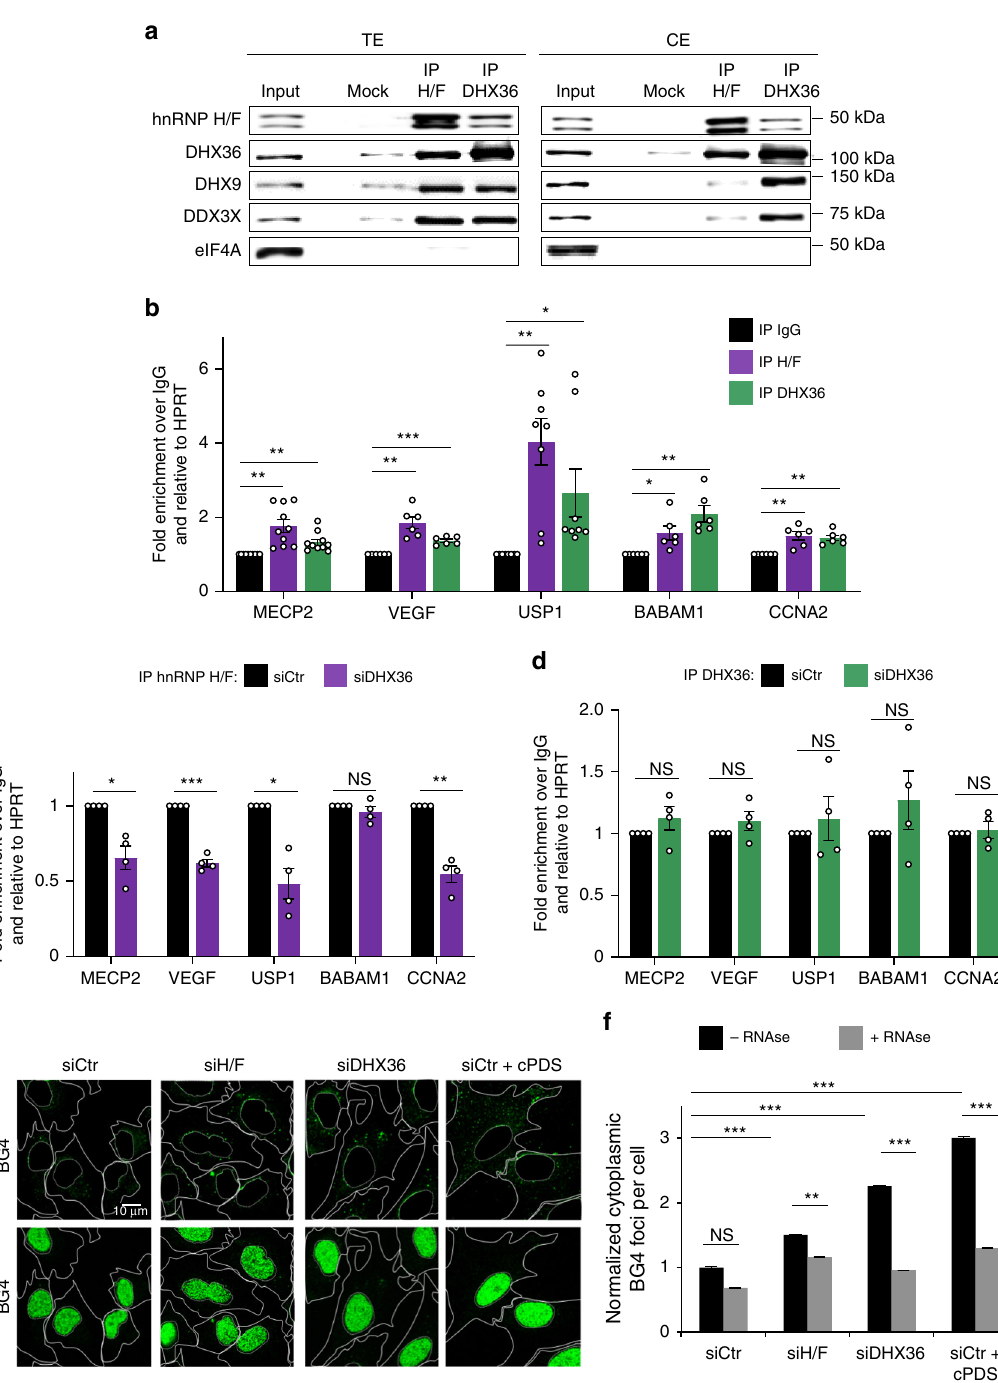
(Fig. 5b, c). Ionizing radiation radiotherapy (IR) and temozolo- mide chemotherapy (TMZ) are part of the standard treatment for GBM patients. The ability of hnRNP H/F to induce DDR markers prompted us to determine whether hnRNP H/F silencing could enhance the cytotoxic effects of IR or TMZ. To this end, we depleted hnRNP H/F in the chemo- and radio-resistant GBM cell line LN18 and either analyzed DNA damage repair by monitoring H2AX phosphorylation or measured the cell survival fraction using clonogenic assays, after treatment with IR (Fig. 5d, e and Supplementary 10a – c) or TMZ (Supplementary 10d, e). Our results showed that hnRNP H and/or hnRNP F silencing induced a marked increase in γ -H2AX after exposure to IR (Fig. 5d and NATURE COMMUNICATIONS|